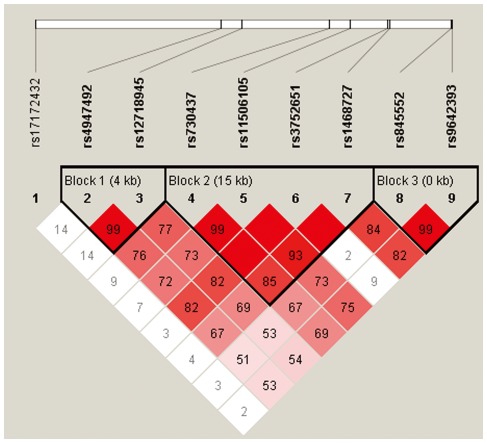
Haplotype block map for all the tSNPs of the EGFR gene.Block 1 includes rs4947492 and rs12718945; Block 2 includes rs730437, rs11506105, rs3752651 and rs1468727; and Block 3 includes rs845552 and rs9642393. The LD between two SNPs is standardized D′ (red schemes).